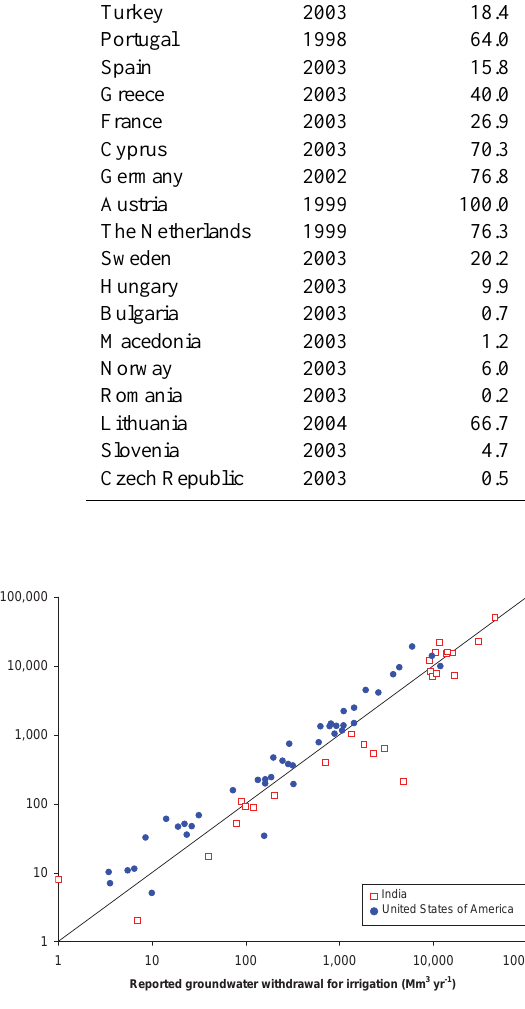
Fig. 6. Computed consumptive groundwater use for irrigation versus reported annual groundwater withdrawals for irrigation in federal states and union territories of India and irrigation water application from groundwater in federal states of the conterminous USA (data sources: Central Ground Water Board, 2006; Veneman et al., 2004).